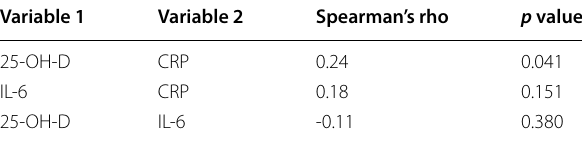
Table 5 Bivariate correlation between biological